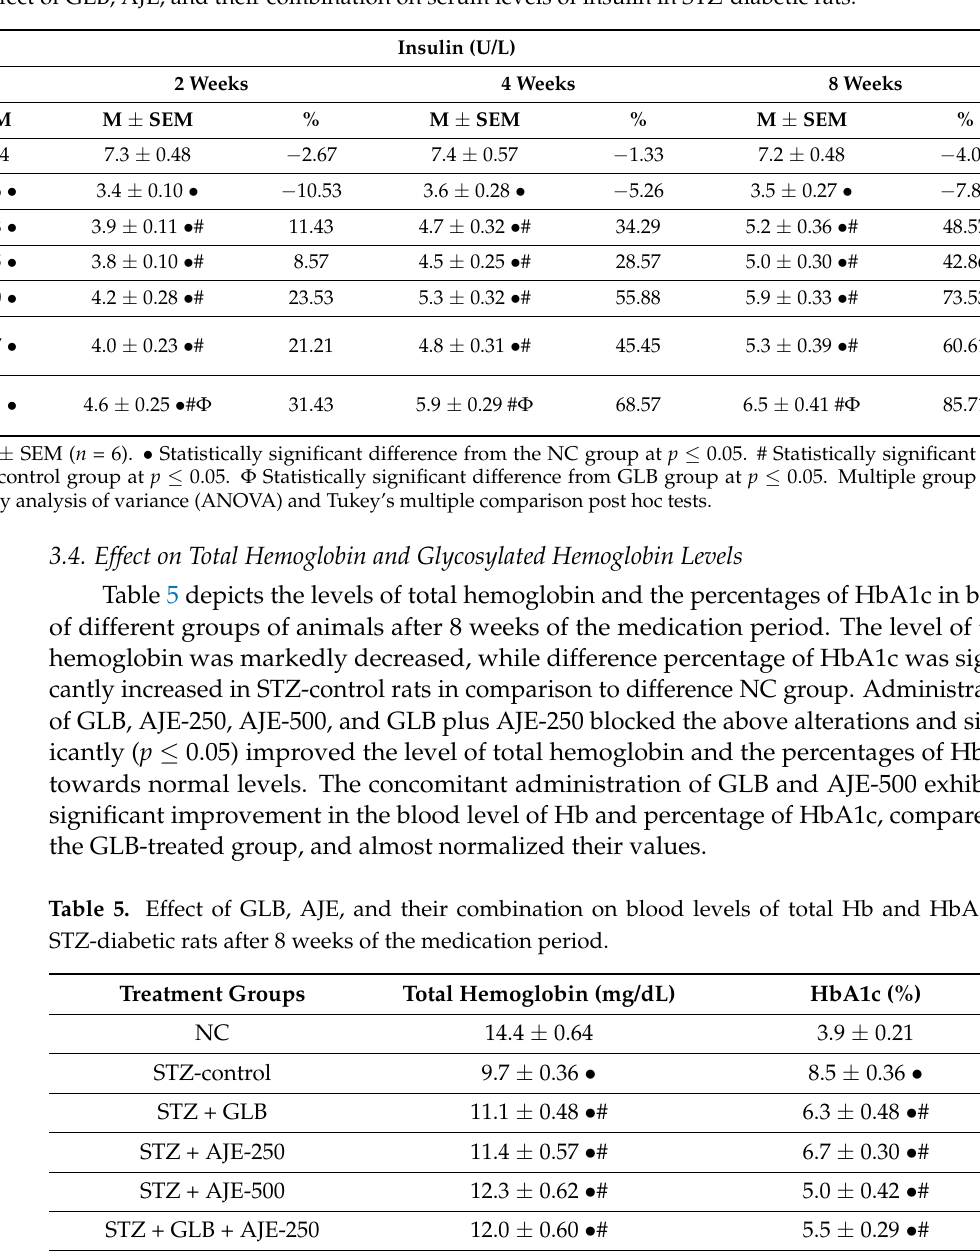
Table 4. Effect of GLB, AJE, and their combination on serum levels of insulin in STZ-diabetic rats. Treatment Groups